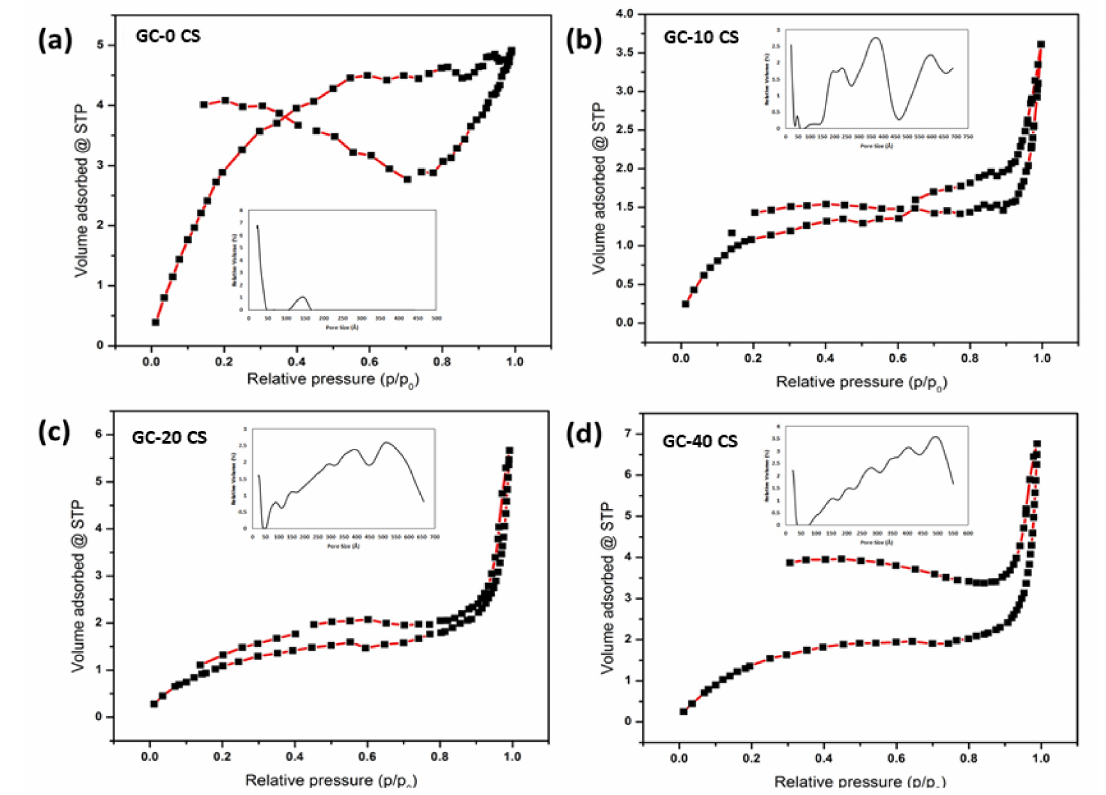
Figure 4. BET analysis: ( a ) GC-0 CS, ( b ) GC-10 CS, ( c ) GC-20 CS, and ( d ) GC-40 CS scaffolds. The two axes are the relative pressure and the volume adsorbed at STP.